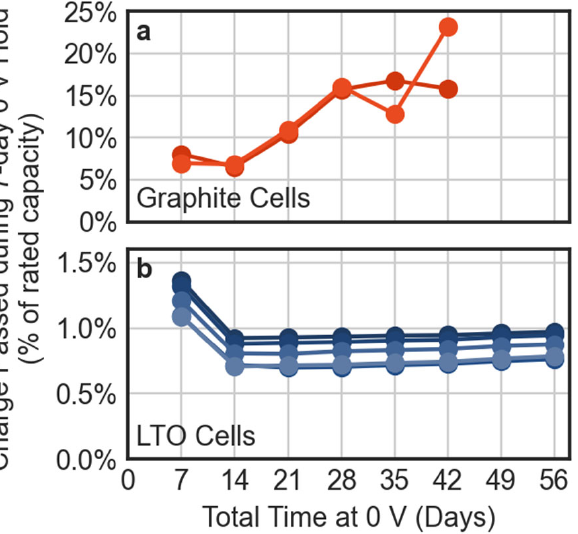
Figure 6. Total charge passed by each cell during each 7-day hold at 0 V. Graphite ( a ) and LTO ( b ) cells are presented separately.